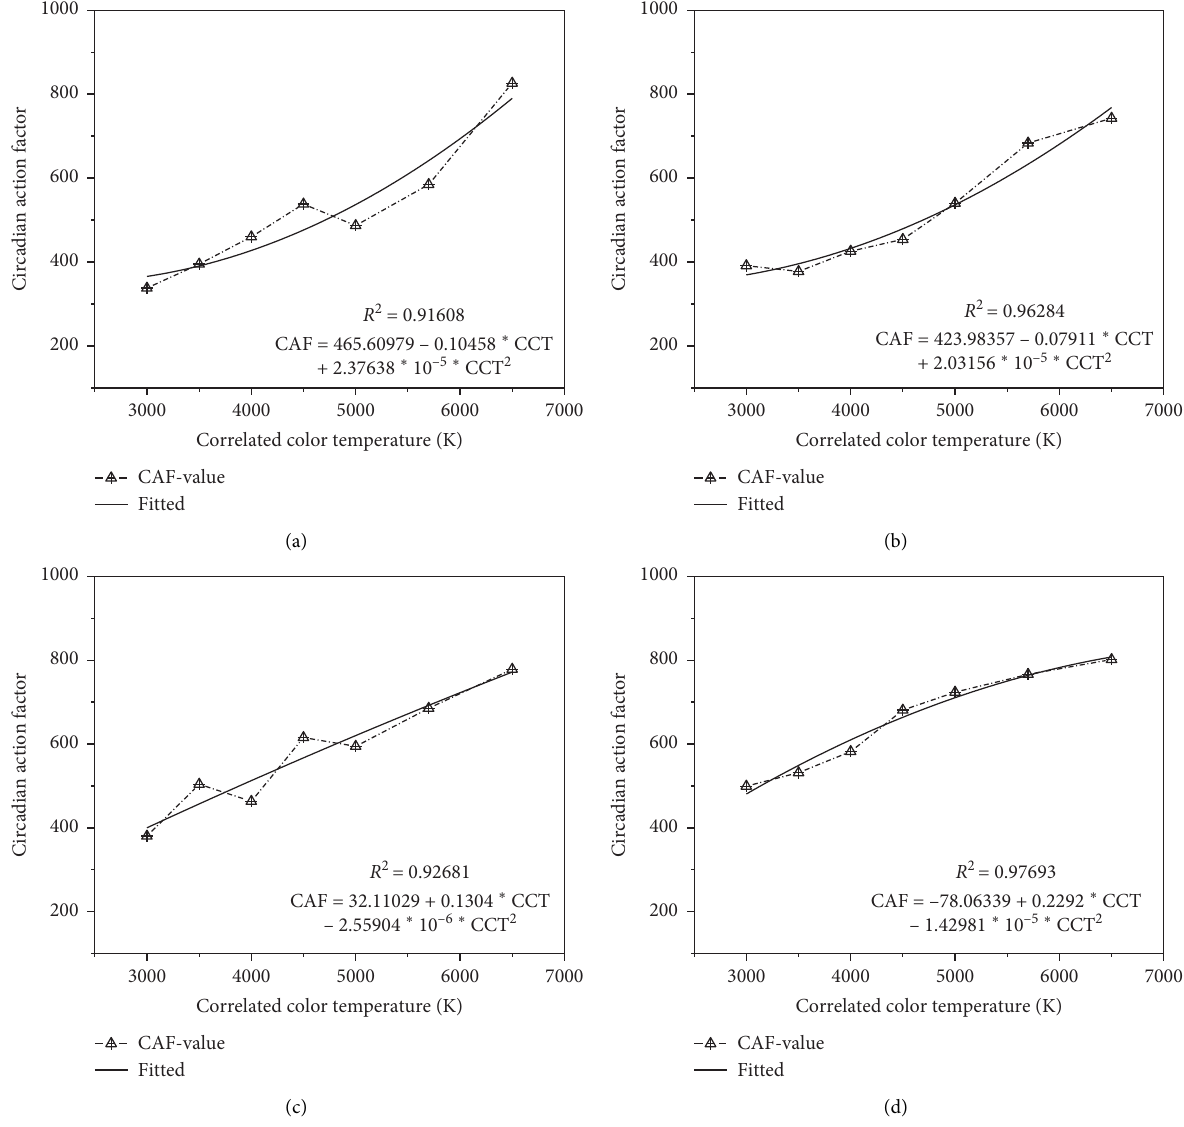
Figure 5: Circadian action factor. (a) CRI2012 � 65. (b) CRI2012 � 75. (c) CRI2012 � 85. (d) CRI2012 �